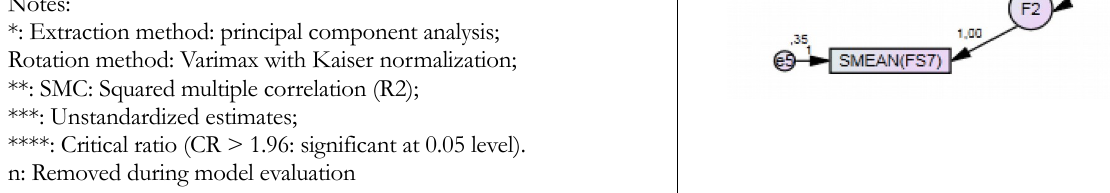
Table 17. EFA and CFA of the FS